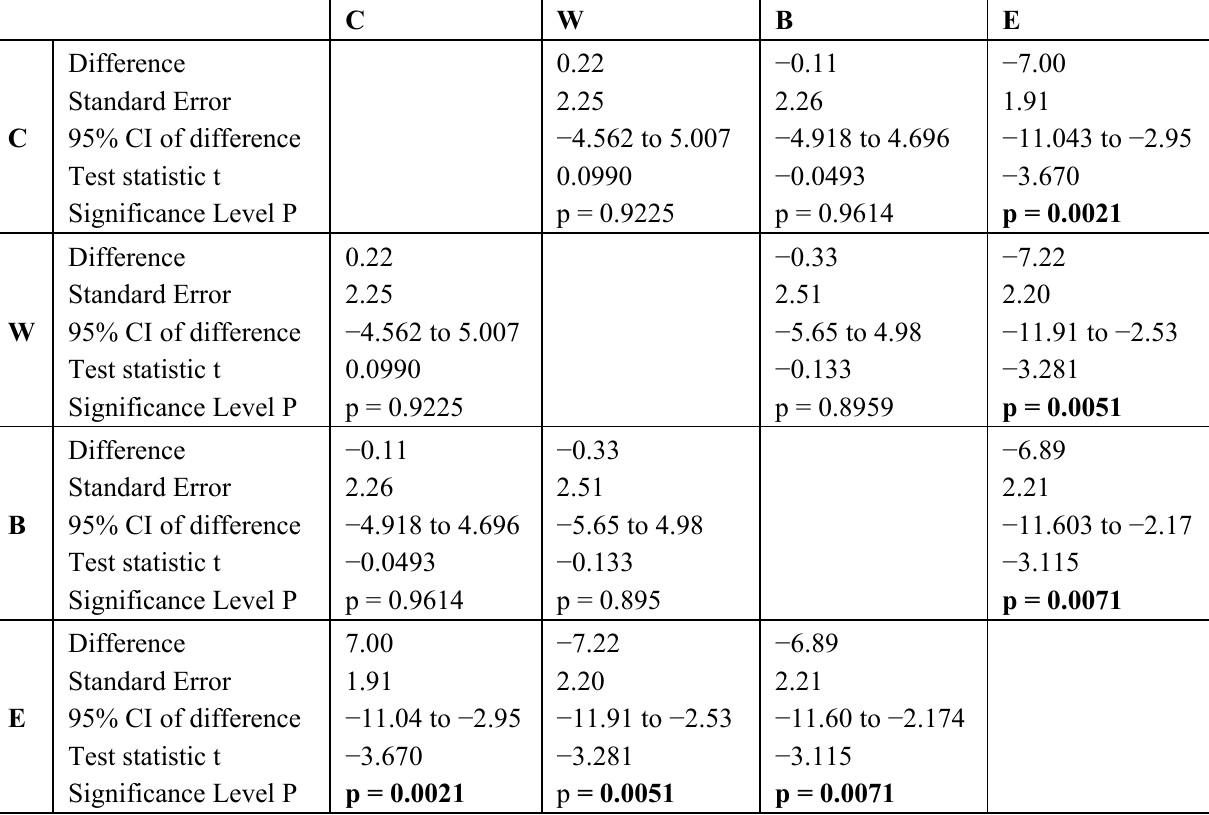
Table 8. Statistical difference between mean values of the average number of electro-stimulations necessary for the development of kindling threshold after-discharge